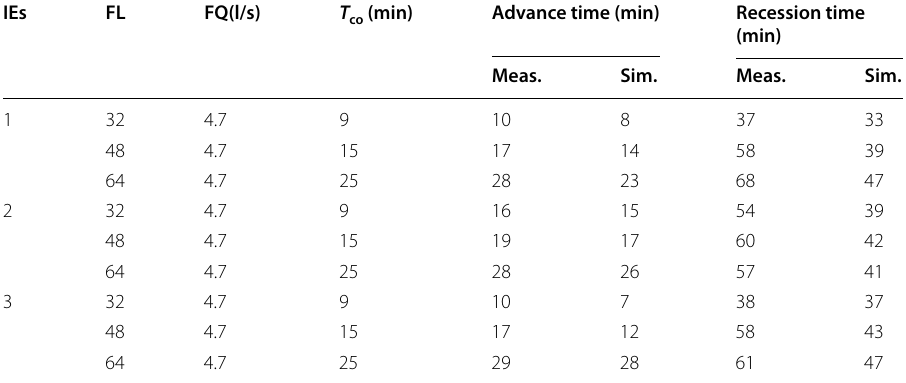
Table 3 Measured and simulated irrigation time under existing irrigation practices